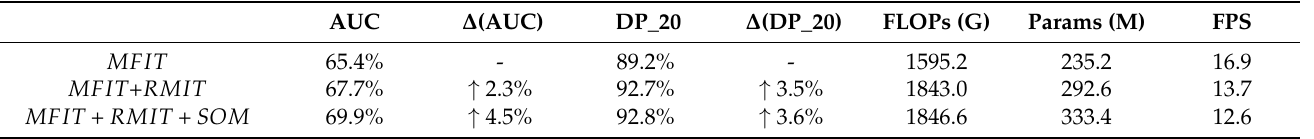
Table 7. The AUC score, DP_20 value, FLOPs, Params, and FPS about the ablation study of each critical component in